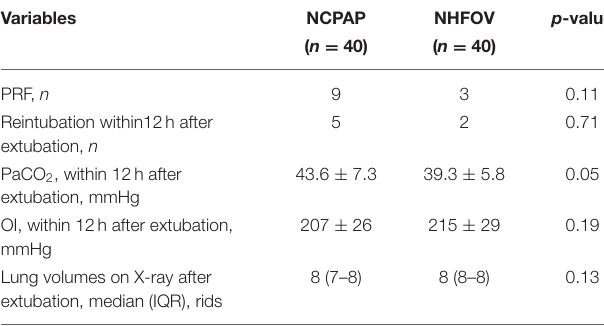
TABLE 2 | The primary outcomes between NCPAP treatment and NHFOV treatment.